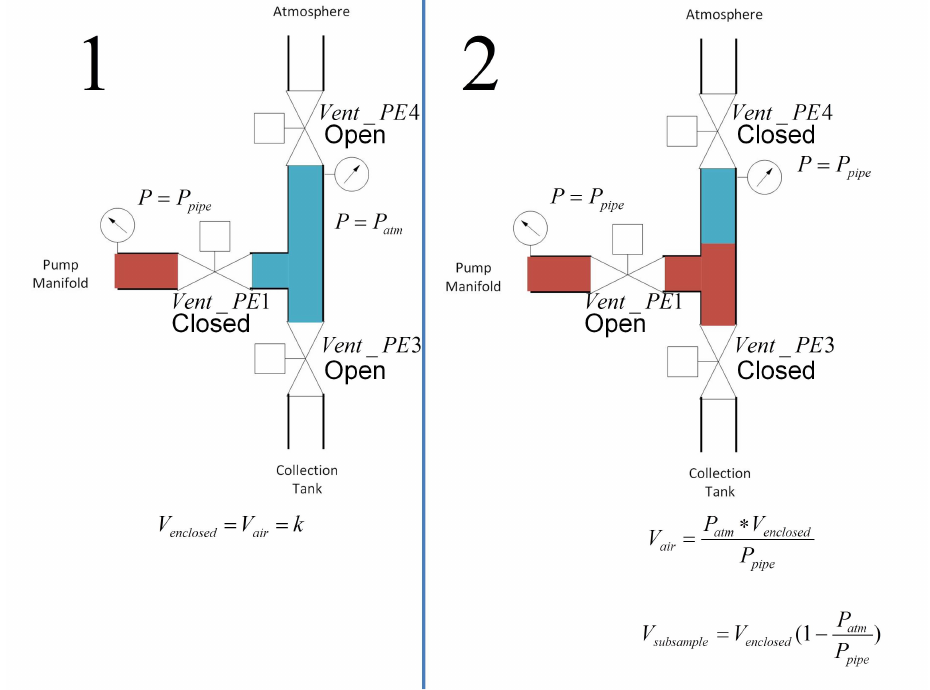
Figure 2. Subsample dosing. 1: Valves position before taking subsample. 2: Valves position after taking the sample. (red = digestate , blue = air).